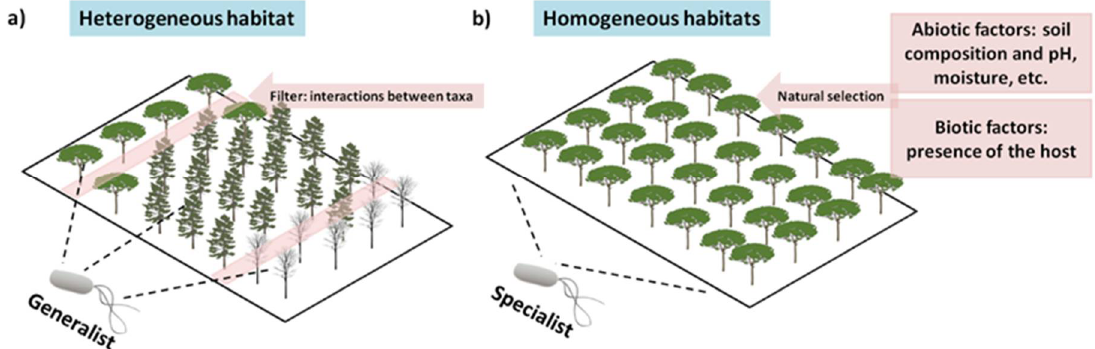
Figure 4. Development of habitat specialization in microbial species. More heterogeneous or disturbed environments tend to be occupied by generalist species ( a ), whereas specialist species tend to develop in more homogeneous or constant environments and are determined by natural selection ( b ).